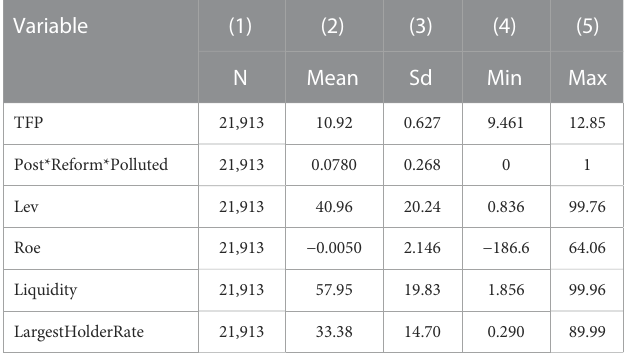
TABLE 1 Summary statistics of main variables.